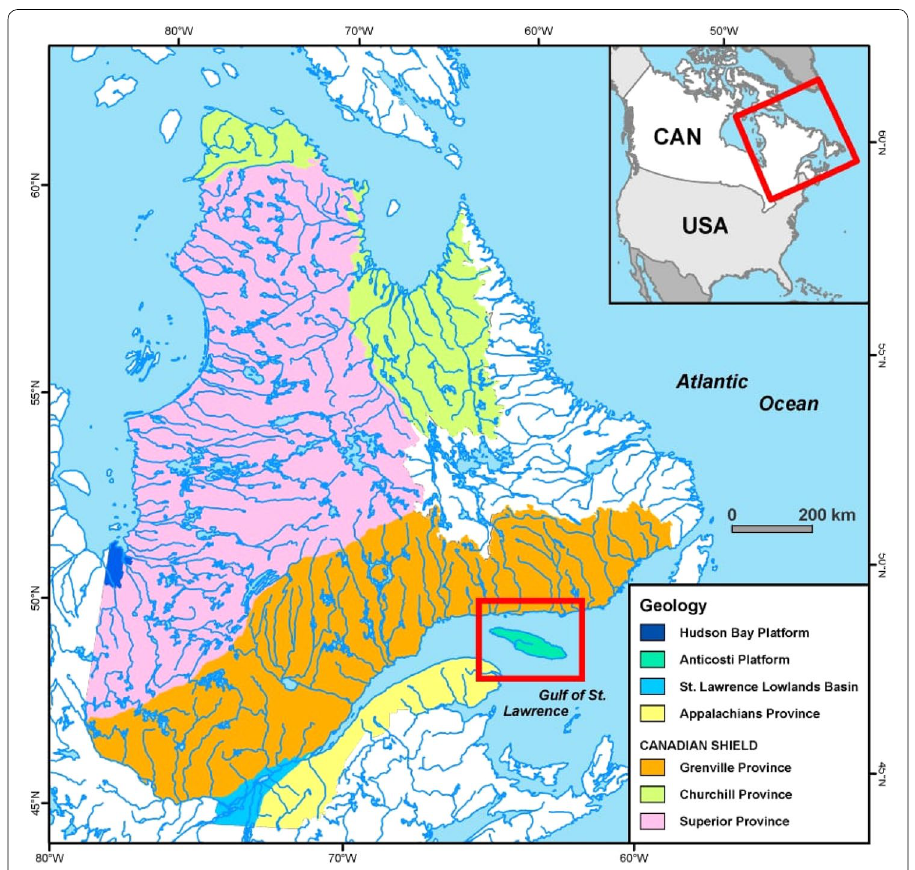
Fig. 1 General geological map of the Province of Québec, and location of the Anticosti Island (modified from Comeau et al.